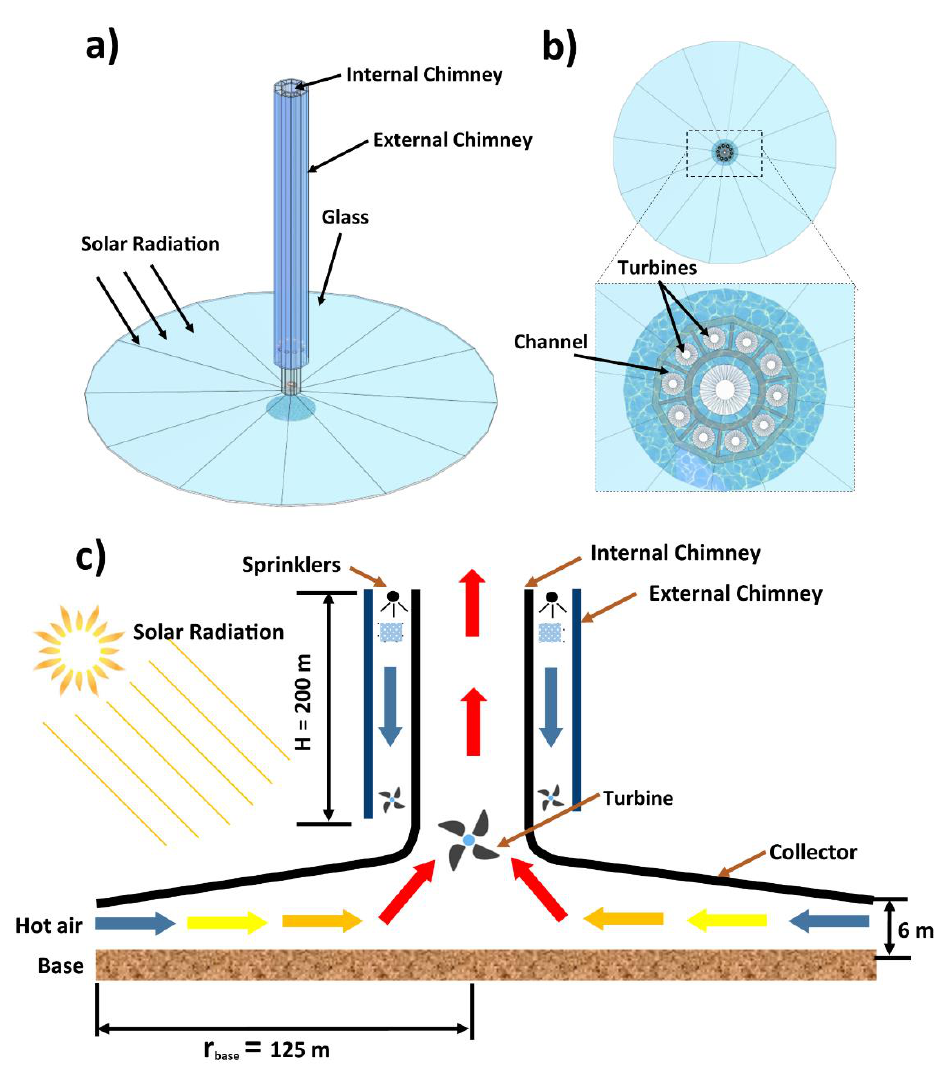
Figure 1. Diagram of the proposed solar double-chimney power plant design: ( a ) a three-dimensional view, ( b ) view from the top section, ( c ) cross-sectional view.